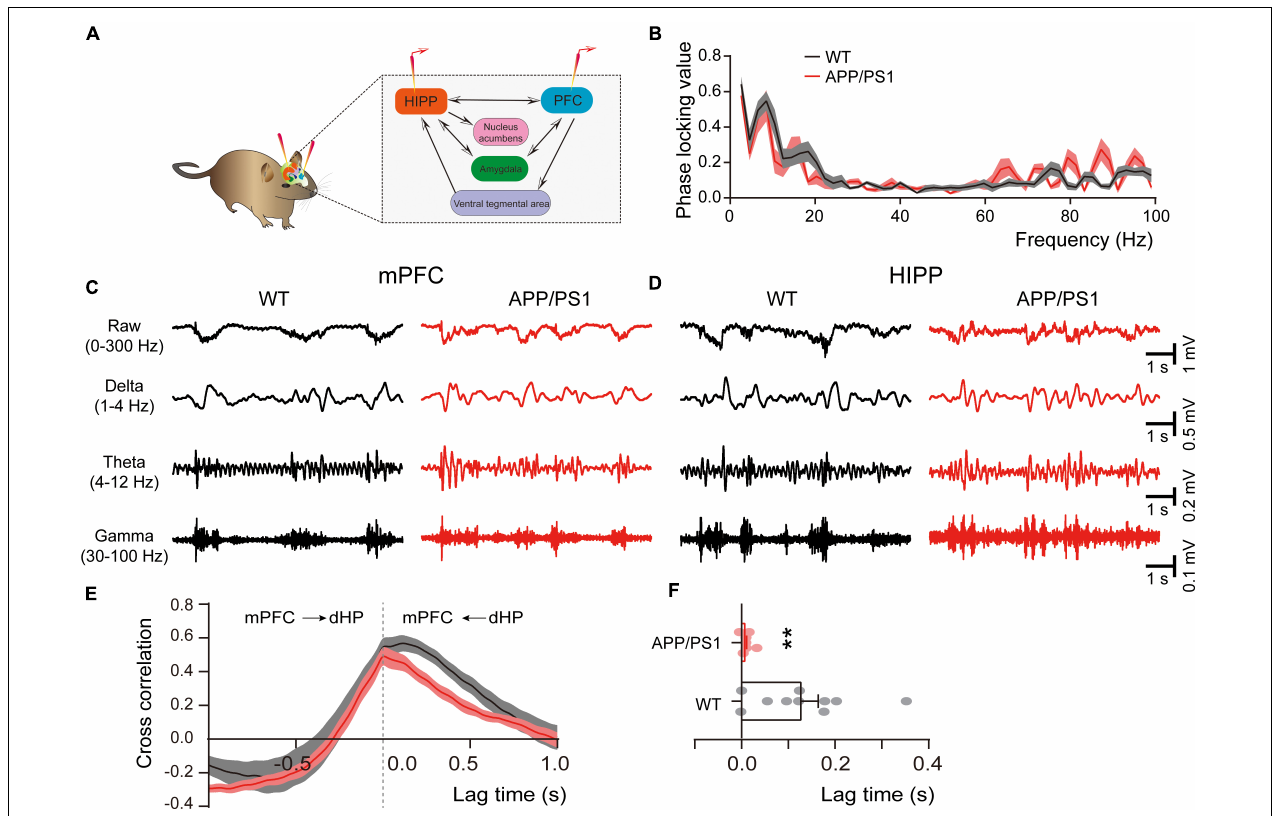
FIGURE 5 | Altered connectivity between mPFC and HIPP of 4 ∼ 5 month-old APP/PS1 mice. (A) Schematic diagram showing in vivo dual-site LFP recording in the HIPP-mPFC. (B) The phase-locking curve between frequency ranges. (C,D) Representative traces of extracellular LFPs, as well as filtered delta, theta, and gamma oscillations, were recorded simultaneously in the mPFC and HIPP. (E) The LFP signals between mPFC and HIPP have approximately symmetrical cross-correlation values for positive (HIPP leading) and negative (mPFC leading) time lags in WT and APP/PS1, suggesting bidirectional communication between these two brain areas. (F) Quantification shows a significantly decreased cross-correlation value at positive time lag ranges between HIPP and mPFC in 4 ∼ 5 month-old APP/PS1 mice, indicating decreased synchronization between the two regions. WT: n = 10 mice; APP/PS1: n = 8 mice; two-sample t -test. Values represent the mean ± SEM, ** p <